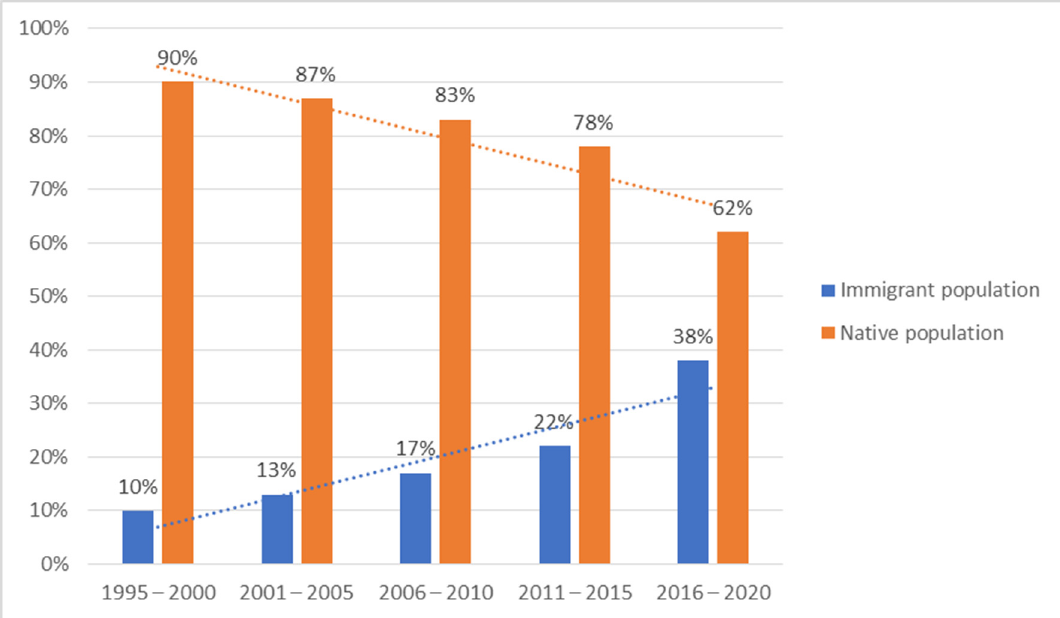
Figure 2. Proportion of native and immigrant patients over the study period. There was a diagnostic delay in 69% of cases, with a mean patient-attributable delay of 31 ± 20 days (range 9–100) and a mean total delay of 36 ± 29 days (range 7–142). Table 1 displays the time to thoracentesis/biopsy, time to beginning of treatment, and length of hospital Of all patients, 73% were referred from the Emergency Department, 17% by their GP and 10% by other specialists. Onset duration was acute in 35% of patients, subacute in 26% and prolonged in 39%. The most common symptom was pleuritic chest pain (83%), followed by fever (76%), cough (65%), dyspnoea (63%), constitutional symptoms (32%), purulent sputum (20%) and haemoptysis (1%).